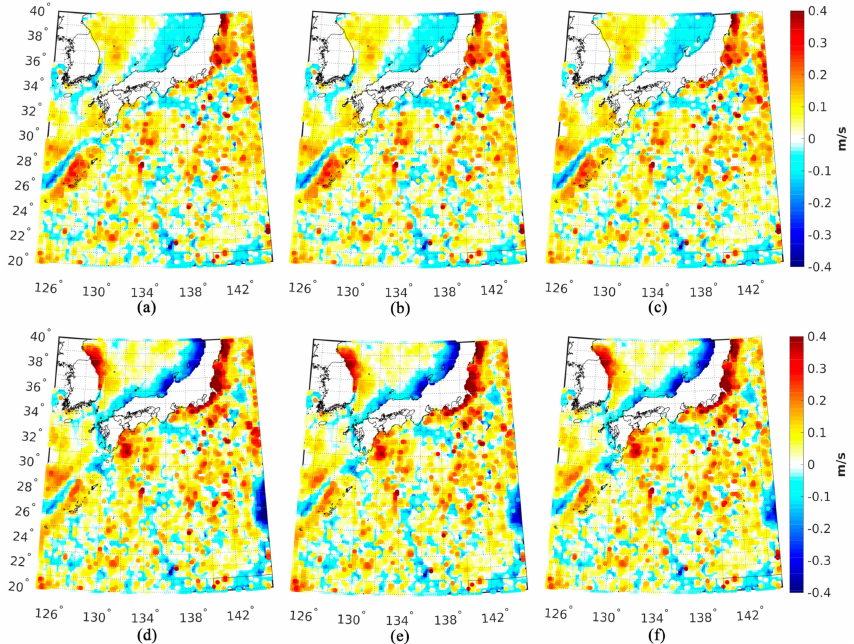
Figure 10. The differences in meridional geostrophic velocities between buoy data and information deduced from the MDT solutions: ( a ) DTU18DIRR4-MDT; ( b ) DTU18DIRR5-MDT; ( c ) DTU18DIRR6- MDT; ( d ) GF-R4-MDT; ( e ) GF-R5-MDT; ( f )